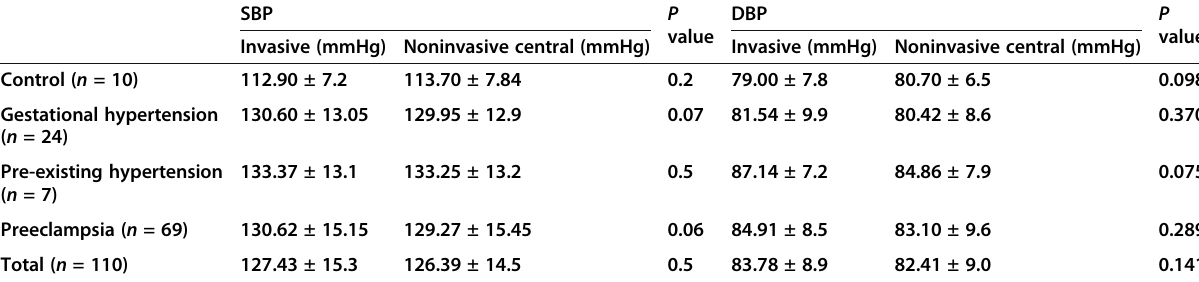
Table 2 Accuracy of non-invasive central against invasive SBP and DBP among the studied